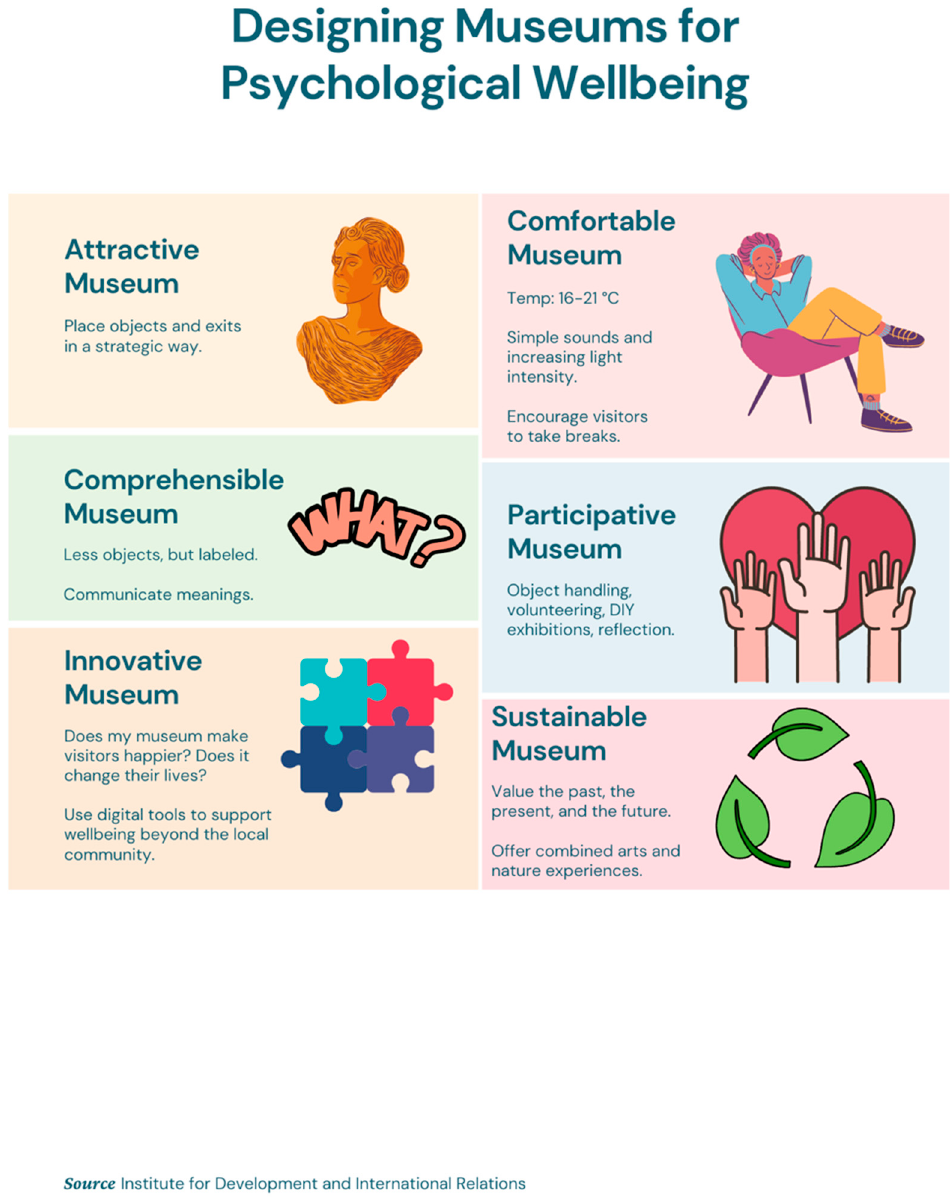
Figure 3. Designing Museums for Psychological Wellbeing.